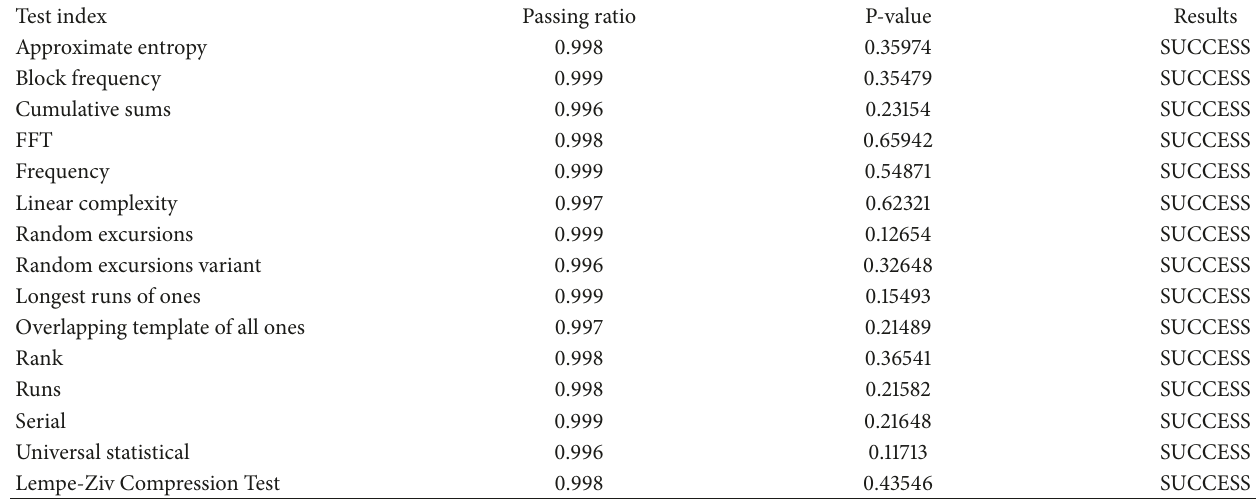
Table 2: The passing ratio and the uniformity of the P-values of each test from the NIST suite.